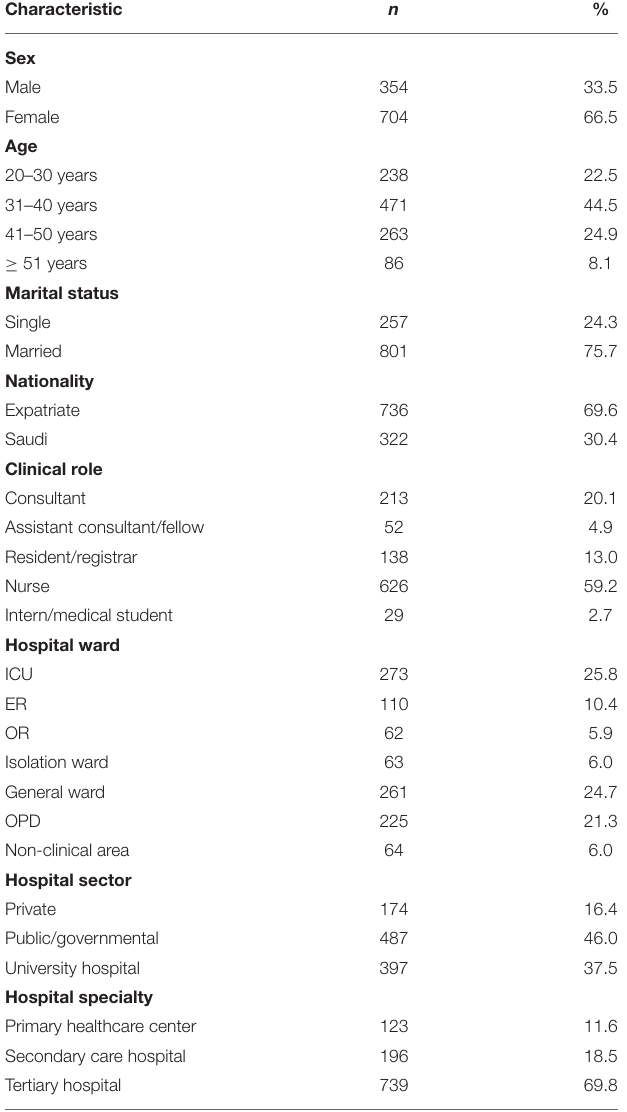
TABLE 1 | Descriptive analysis of HCWs’ sociodemographic and professional characteristics ( N = 1,058).